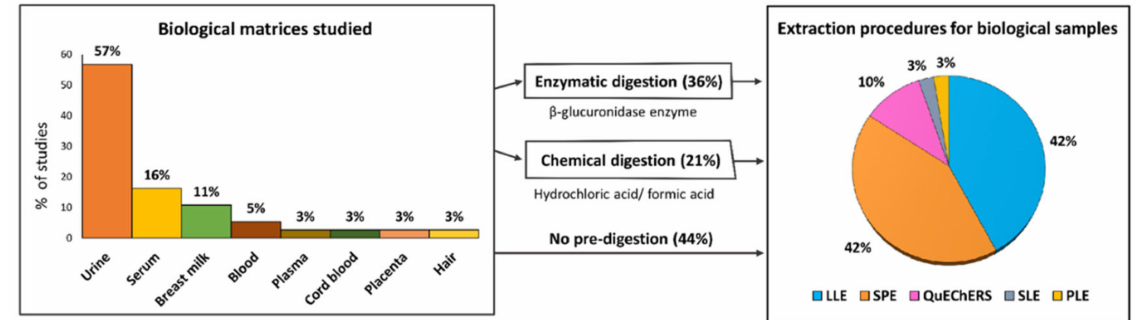
Figure 5. Percentage of studies (2019–2021) according to the biological matrices analyzed and the methodologies followed for sample preparation and subsequent extraction (Source: Table 2). LLE: liquid–liquid extraction; SPE: solid-phase extraction; QuEChERS: Quick, Easy, Cheap, Effective, Rugged, and Safe extraction method; SLE: solid–liquid extraction; PLE: pressurized liquid